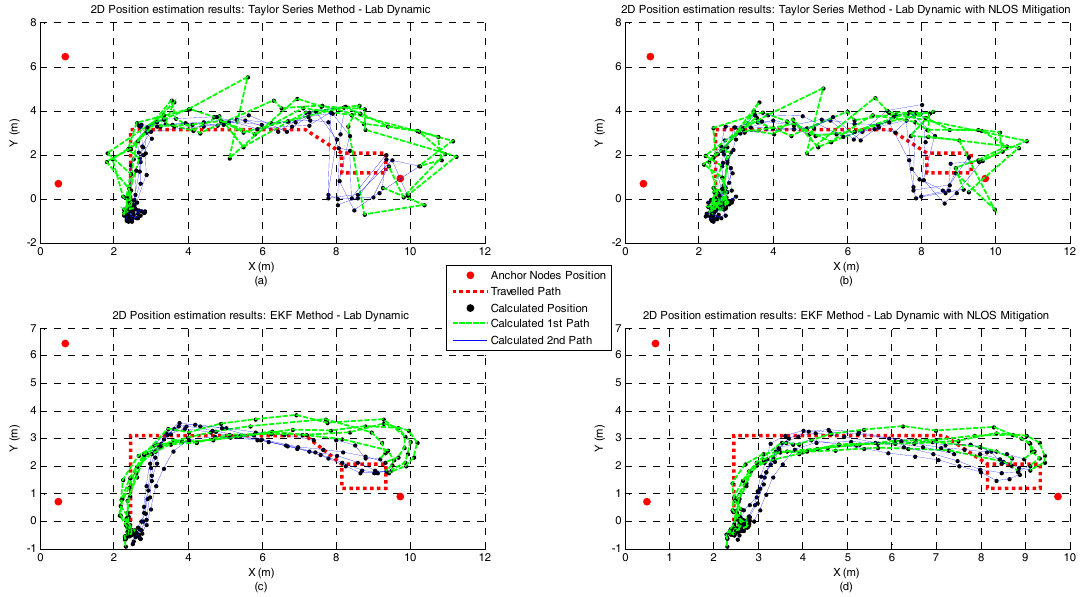
Figure 13. Lab Dynamic test with Taylor Series ( a , b ) and EKF ( c , d ) methods and with and without NLOS identification and mitigation.